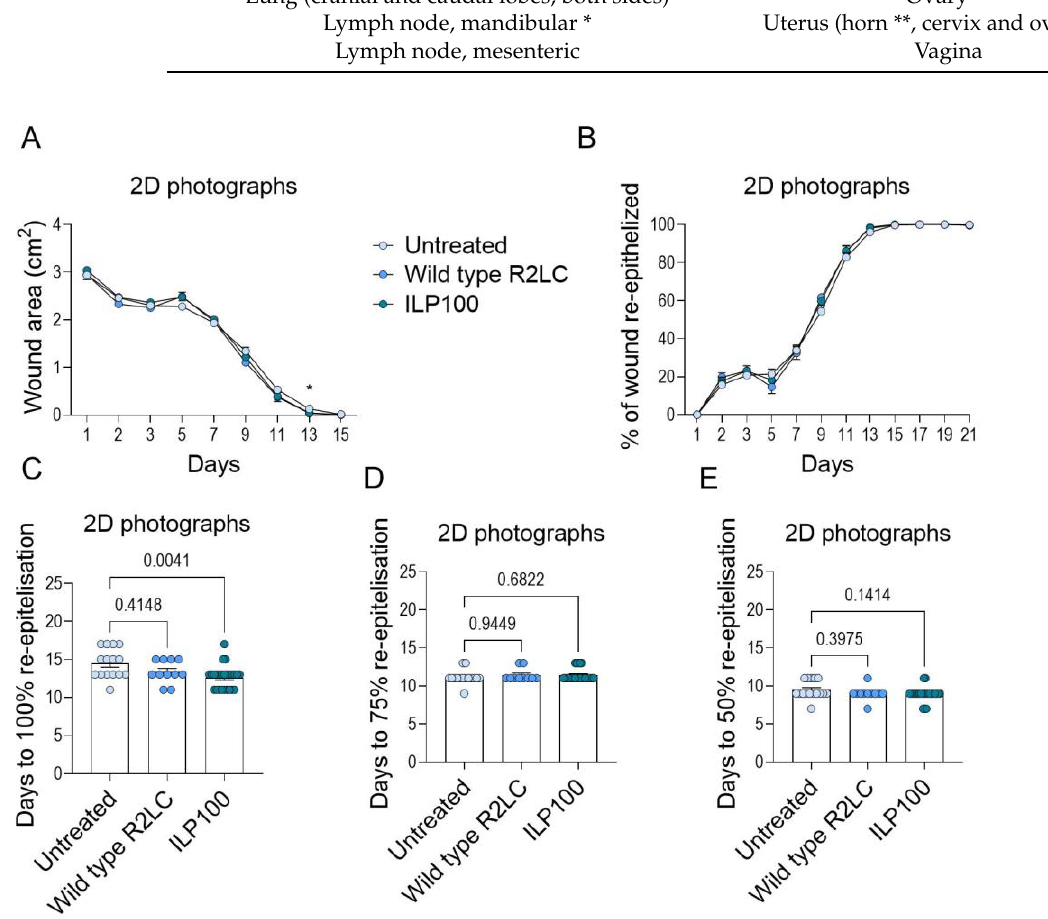
Figure A1. Wound healing assessed from 2D photographs for Cohort A. Wound area and wound healing over time were measured from 2D photographs in Cohort A ( A , B ), and days to 100% ( C ), 75% ( D ), and 50% ( E ) re-epithelization were assessed. ( A , B ): Untreated ( n = 3, N = 18), Wild type R2LC ( n = 3, N = 12), ILP100 ( n = 5, N = 26). ( C – E ): Untreated ( n = 3, N = 18), Wild type R2LC ( n = 3, N = 11), ILP100 ( n = 5, N = 25). Kruskal-Wallis test with Dunnett’s multiple comparison test ( A – E ). * p < 0.05.